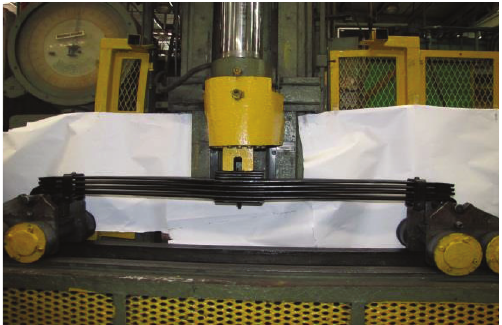
Figure 5: Experimental vertical stiffness test for leaf